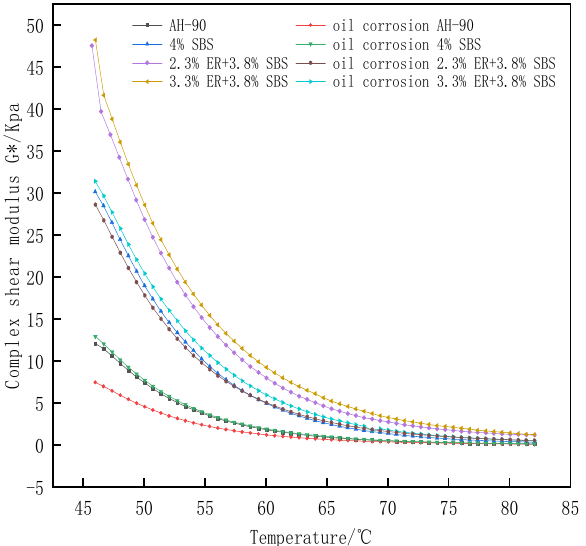
Figure 10. Effect of oil corrosion on the composite shear modulus of ER/SBS modified bitumen.